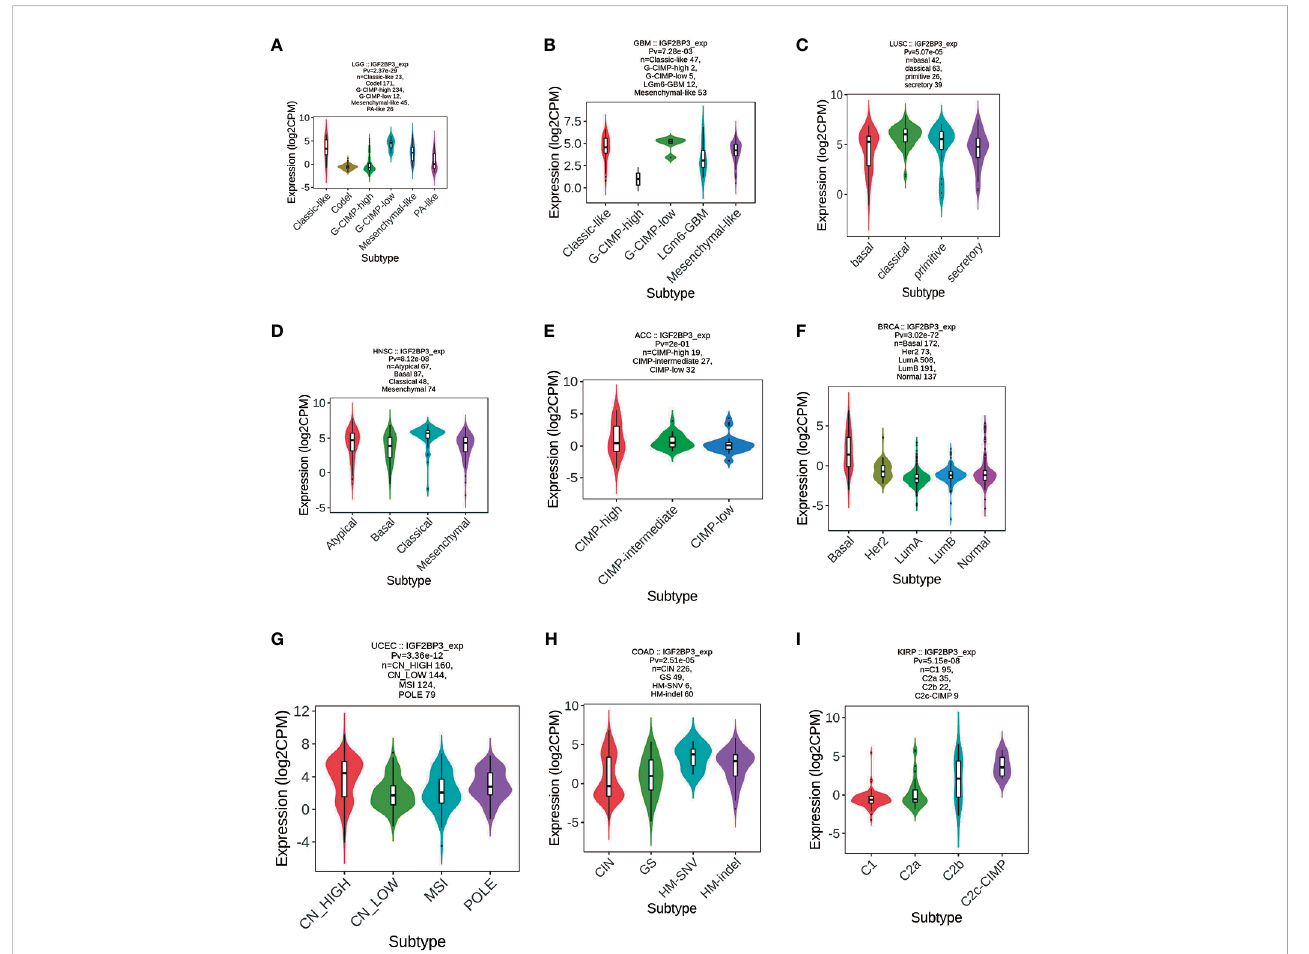
FIGURE 8 Correlations between IGF2BP3 expression and molecular subtypes across TCGA tumors. (A) LGG; (B) GBM; (C) LUSC; (D) HNSC; (E) ACC; (F) BRCA; (G) UCEC; (H) COAD; (I)